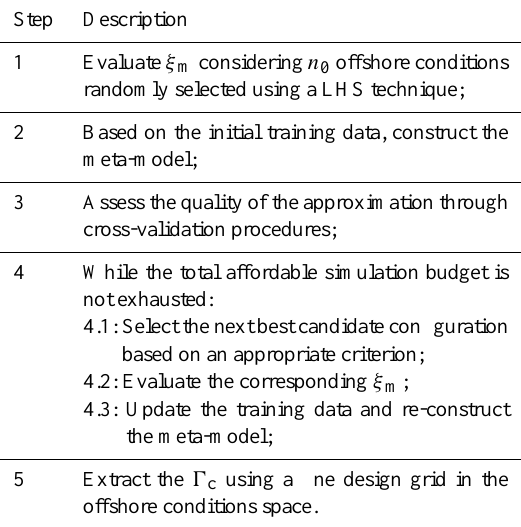
Table 1. Sequential strategy for extracting the critical